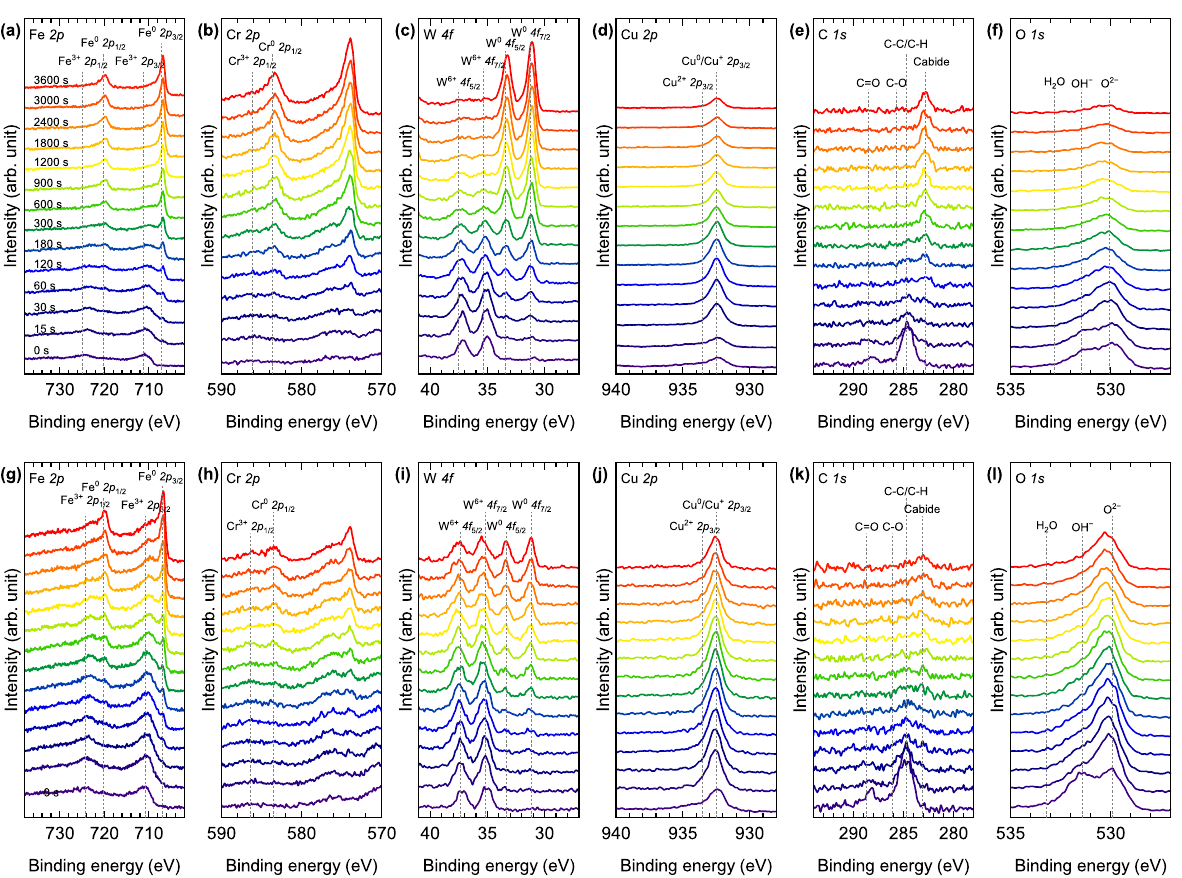
Fig. 8 Depth dependences of the high-resolution XPS pro fi les. a , g Fe 2p , b , h Cr 2p , c , i W 4f , d , j Cu 2p , e , k C 1s , and f , l O 1s peaks for the 16Cr steel samples heat treated at a – f 800 °C and g – l 1100 °C after the 7-h immersion in the 0.5 M H 2 SO 4 solution. The sputtering time where each spectrum was acquired is indicated for each.